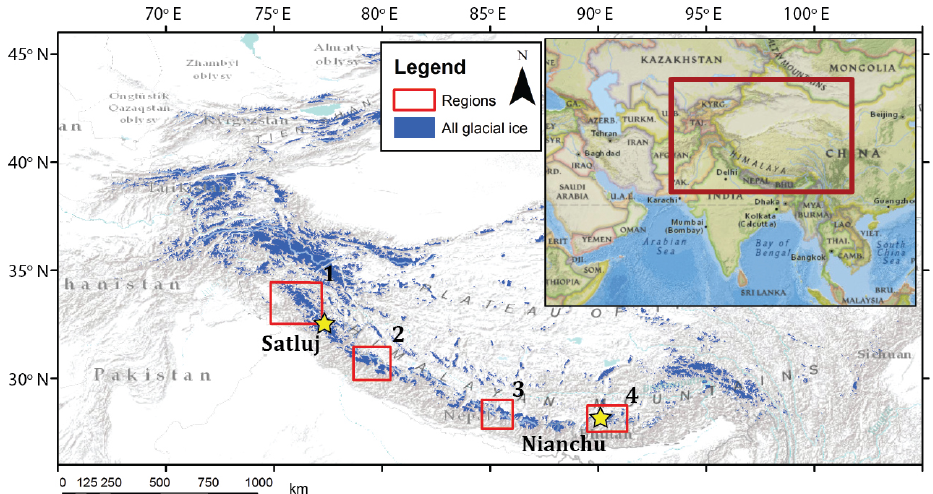
Figure 2. High-mountain Asia, showing glacier ice in blue. Two selected glaciers of interest are shown as yellow stars. Four red boxes indicate the areas selected for regional analysis. Regions are centered on the Jammu Kashmir (1), Himachal Pradesh (2), Everest (3), and Bhutan (4) regions. Glacier shapefiles from Arendt et al. (2015), basemap from ESRI